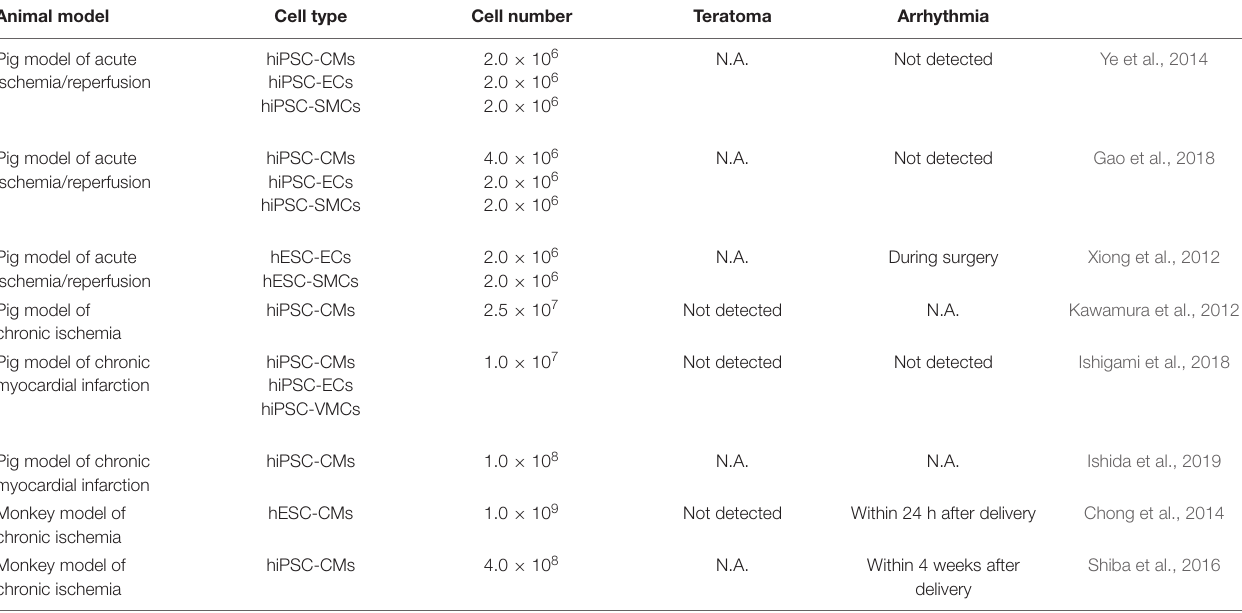
TABLE 1 | Cellular cardiomyoplasty in large animal models using hPSC-derived cardiovascular cells. Animal